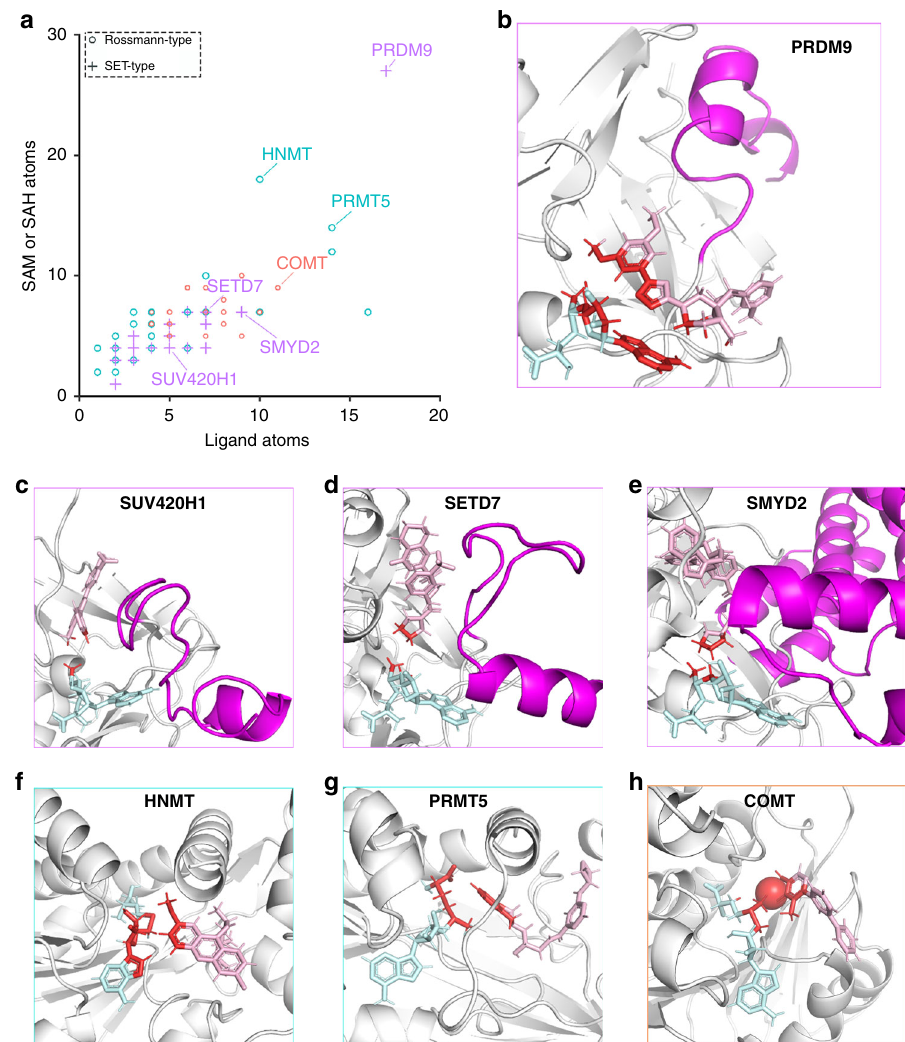
Fig. 4 MRK-740 binding is unique among methyltransferase inhibitors. a Atoms tallied at the interface (distance < 4 Å) between SAM or SAH and small molecule inhibitors. Rossmann-type methyltransferases targeting nitrogen or oxygen are indicated in blue or orange, respectively. The tallied atoms (red) at the interface between SAM or SAH (teal) and small molecule inhibitors (pink) are shown for ( b ) PRDM9 with MRK-470, ( c ) SUV420H1 with 9ZY, ( d ) SETD7 with (R)-PFI-2, ( e ) SMYD2 with AZ506, ( f ) HNMT with Quinacrine, ( g ) PRMT5 with EPZ015666, and ( h ) COMT with a Mg 2 + cation and 43J. The post-SET helices are indicated in purple. PDB accession codes: 6NM4, 5WBV, 4JLG, 5KJN, 1JQE, 4 × 61 and 4XUE, respectively. Data are from Supplementary Table